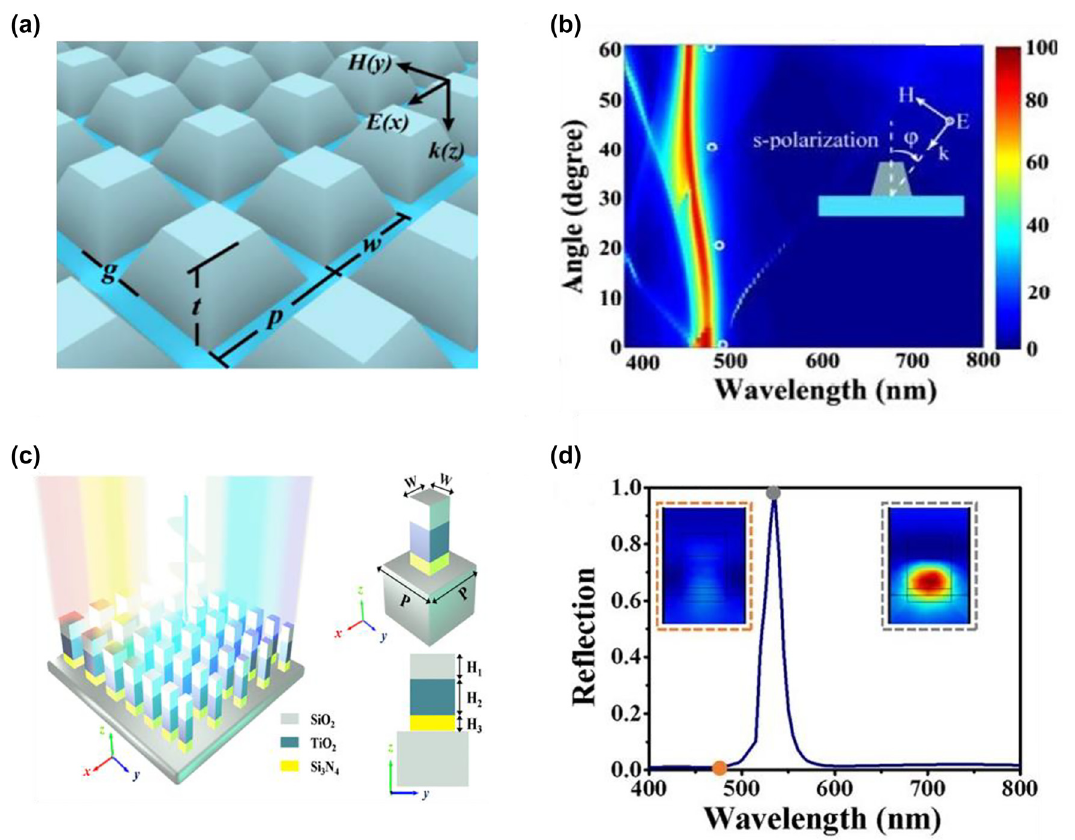
Figure 14: TiO based Mie resonance for structural color generation. (a) Schematic diagram of the TiO -based metasurface, consisting of arrays of 2 2 blocks on a glass substrate. Here, p, w, g and t represent the period, the bottom square width, the gap between the adjacent units, and the block TiO 2 height, respectively. Cross-section of each block is a trapezoid with the trapezoidal corner around 72 ◦ . (b) Angularly-resolved reflection spectra under s-polarized illumination. Inset shows the angle and polarization direction of the incident light. Reproduced with permission [168]. Copyright 2017, American Chemical Society. (c) Schematic illustration of the multi-dielectric-stack metasurface, where each nanopillar is made of a vertically stacked ) SiO capping layer, a 140 nm-thick ( H ) TiO spacer layer, and a 60 nm-thick ( H ) Si N bottom layer. (d) Simulated reflection 100 nm-thick ( H 1 2 2 2 3 3 4